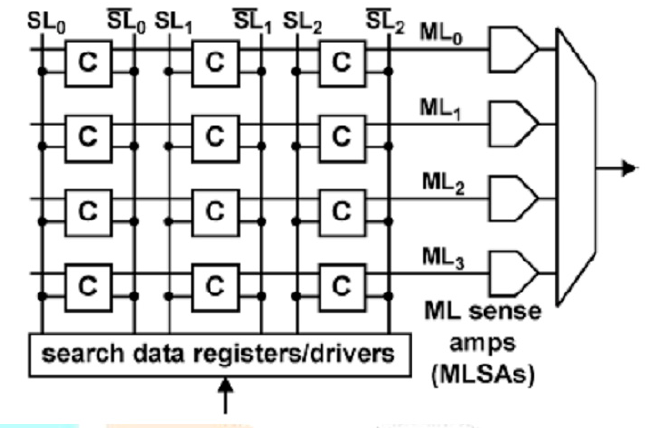
Figure 1. CAM block diagram [18].